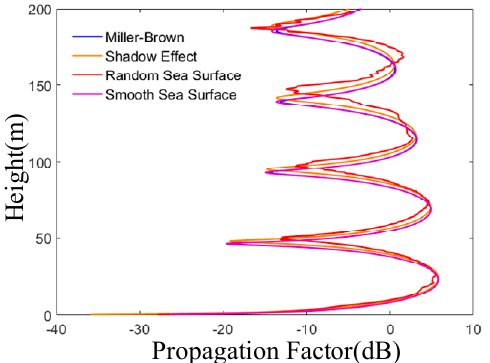
Figure 11. The effects of rough sea surface random on propagation factor. It shows the comparison of propagation factors between a smooth sea surface and a rough sea surface. The roughness attenuation factor of rough sea surface can be divided into Miller-Brown model, shadow effect and random sea surface. The frequency is 1.2 GHz and the wind speed is 7 m/s.